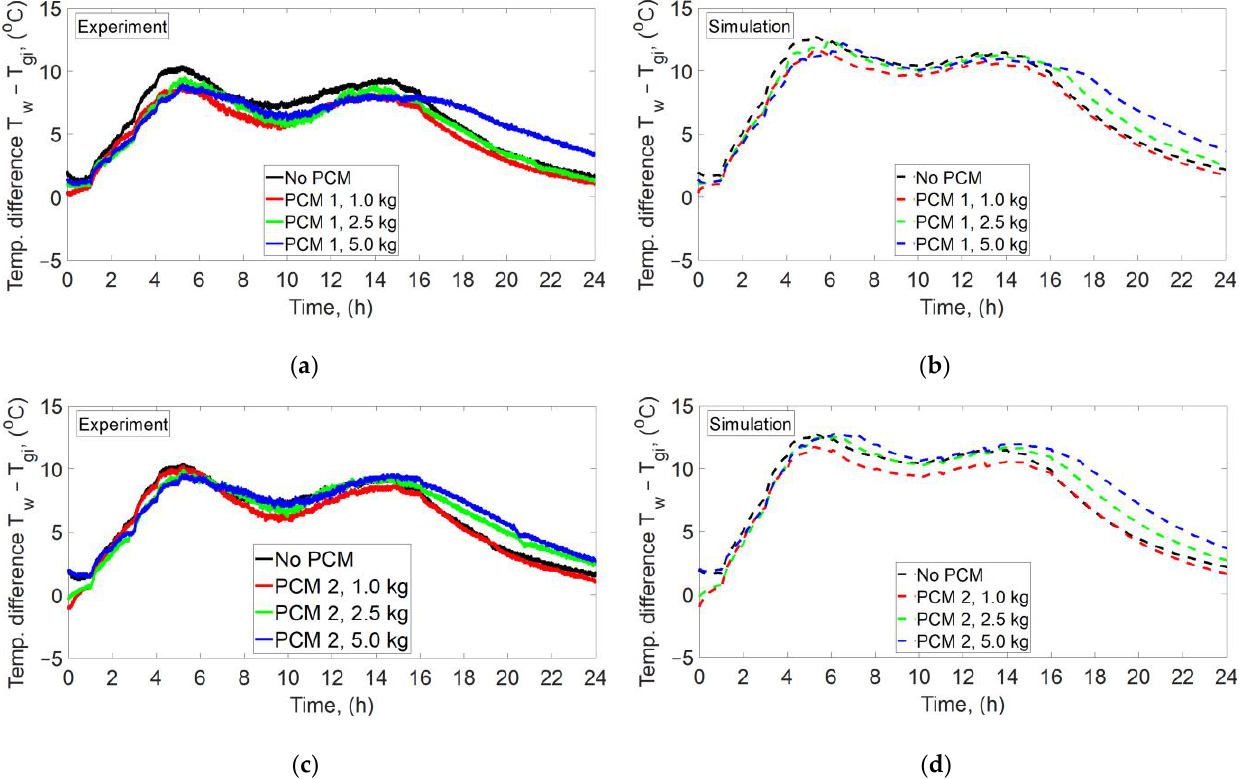
Figure 8. Comparison of the temperature difference between water, (T w ), and inner glass cover, (T gi ),